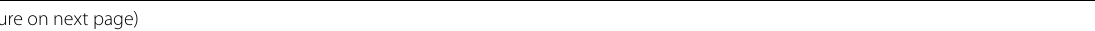
Figure S3) showing that 96.4% of the residues fell within the favored region. The PROSA analysis of the model energy, and the overall Z-score is 6.4. In the superim- − posed structure, the region flanking (10 bp) the unique